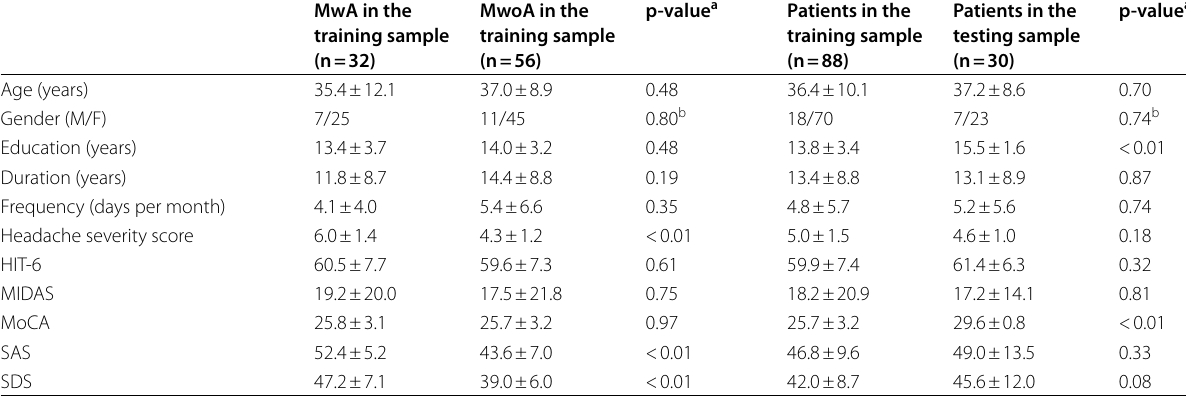
Table 1 The demographic and clinical outcome of all patients